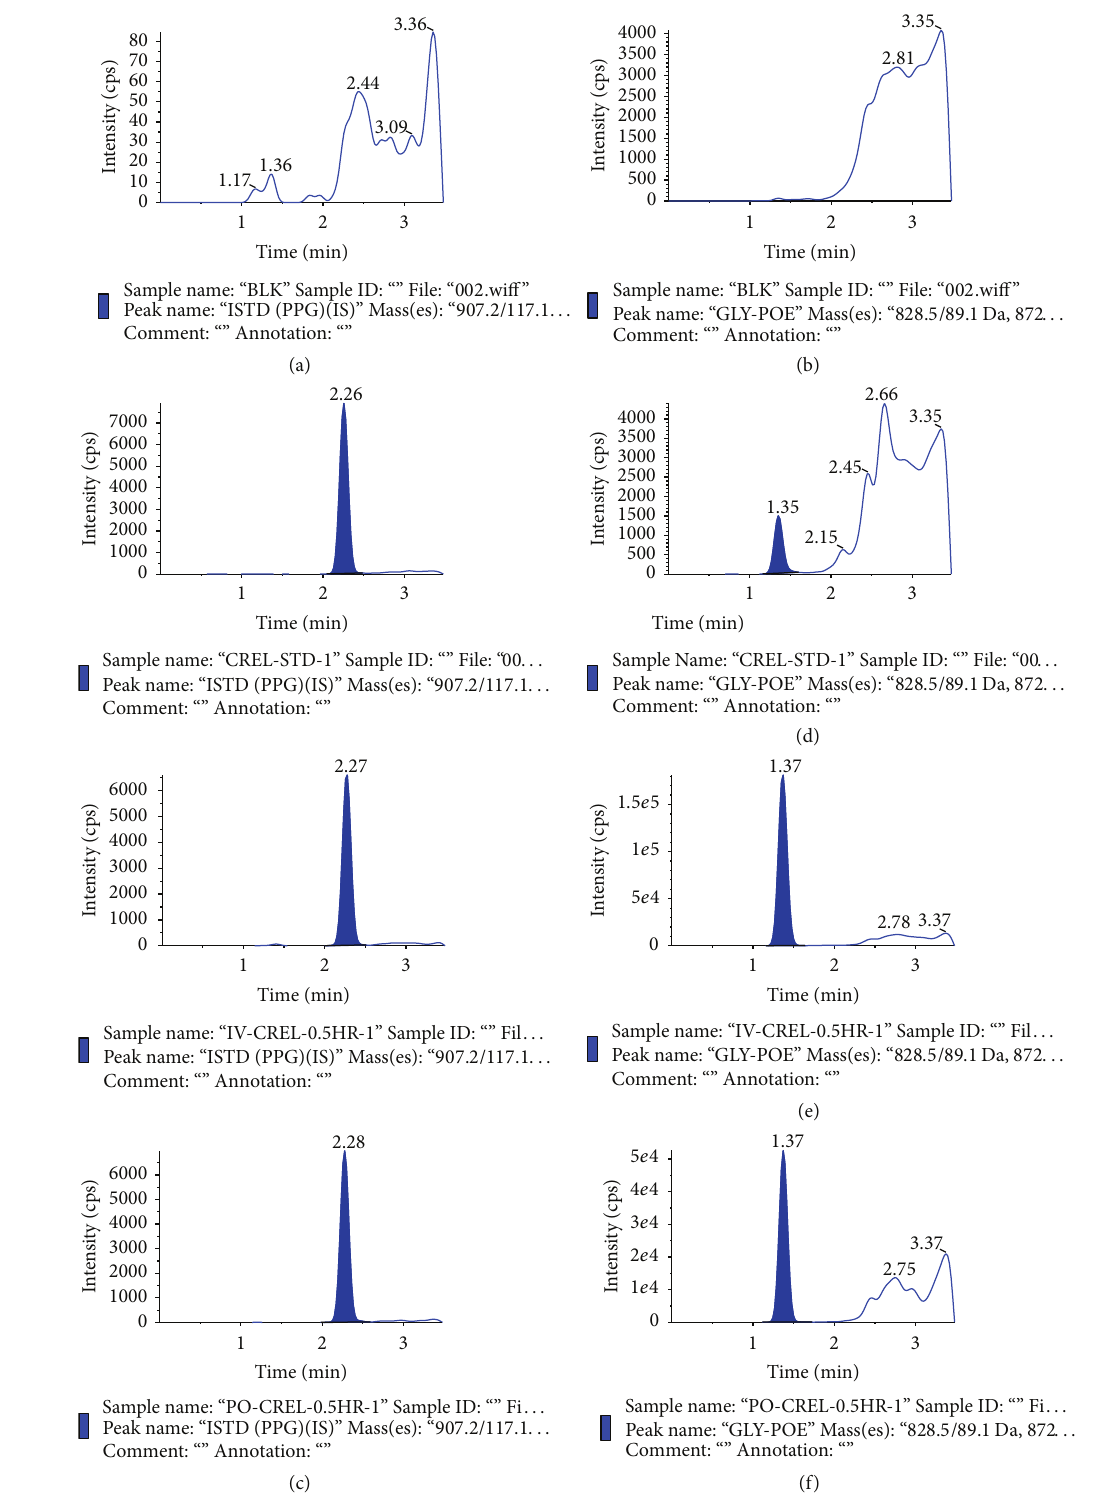
Figure 6: MRM LC-MS/MS chromatograms of (a) PPG in blank rat plasma; (b) CrEL-PEG in rat blank plasma; (c) PPG spiked at 10 𝜇 g/mL concentrationinratplasma;(d)Ratplasmasamplespikedwith1.00 𝜇 g/mLofCrEL-PEG;(e)plasmasampleobtained0.50 hrafterintravenous administration of CrEL to SD rats; (f) plasma sample obtained 0.50 hr after oral administration of CrEL to SD